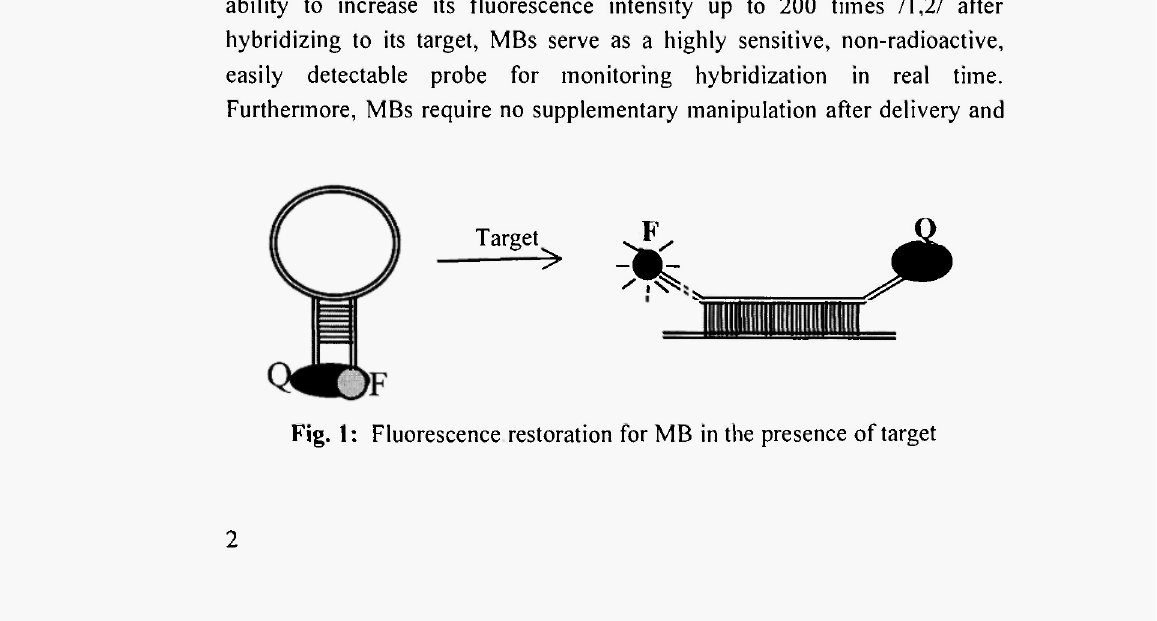
Fig. 1: Fluorescence restoration for MB in the presence of